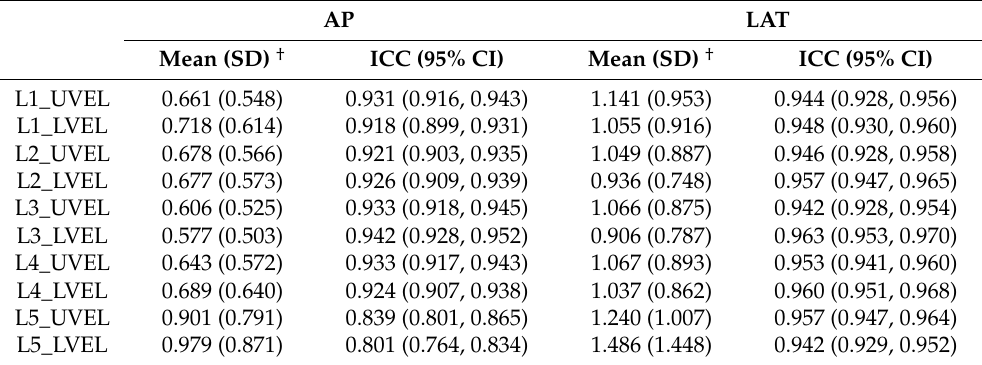
Table 4. Mean variations and inter-rater reliability of the angles of the UVEL and LVEL assessed by all 12